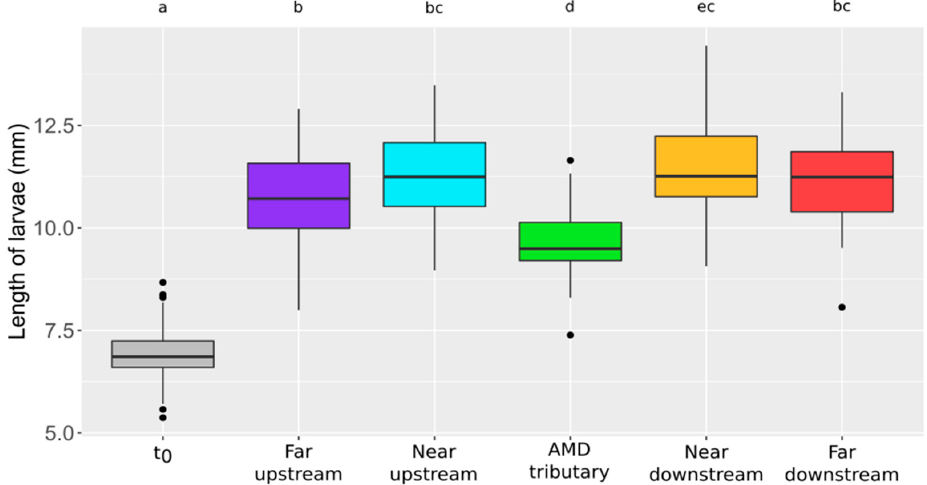
Figure 5. Boxplots of length of larvae (mm) according to the station (30 < n < 58). t 0 : beginning of the exposure ( n = 60). Statistical and significant differences between the stations are identified by different letters.